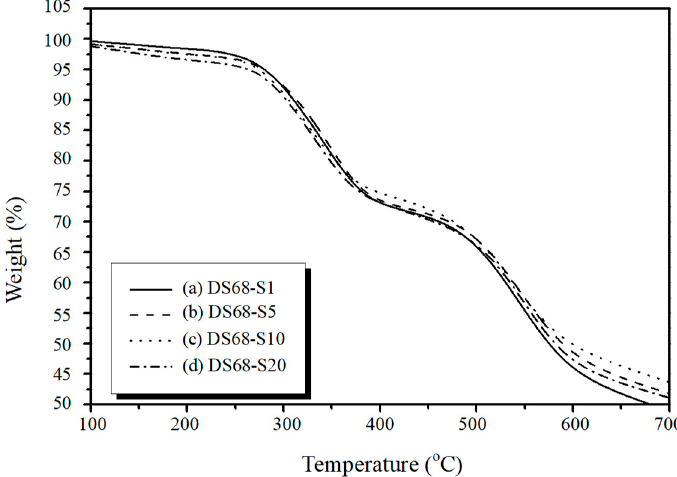
Figure 5. Thermal gravimetric analysis (TGA) thermographs of the original PEEK and sPEEK membrane samples.